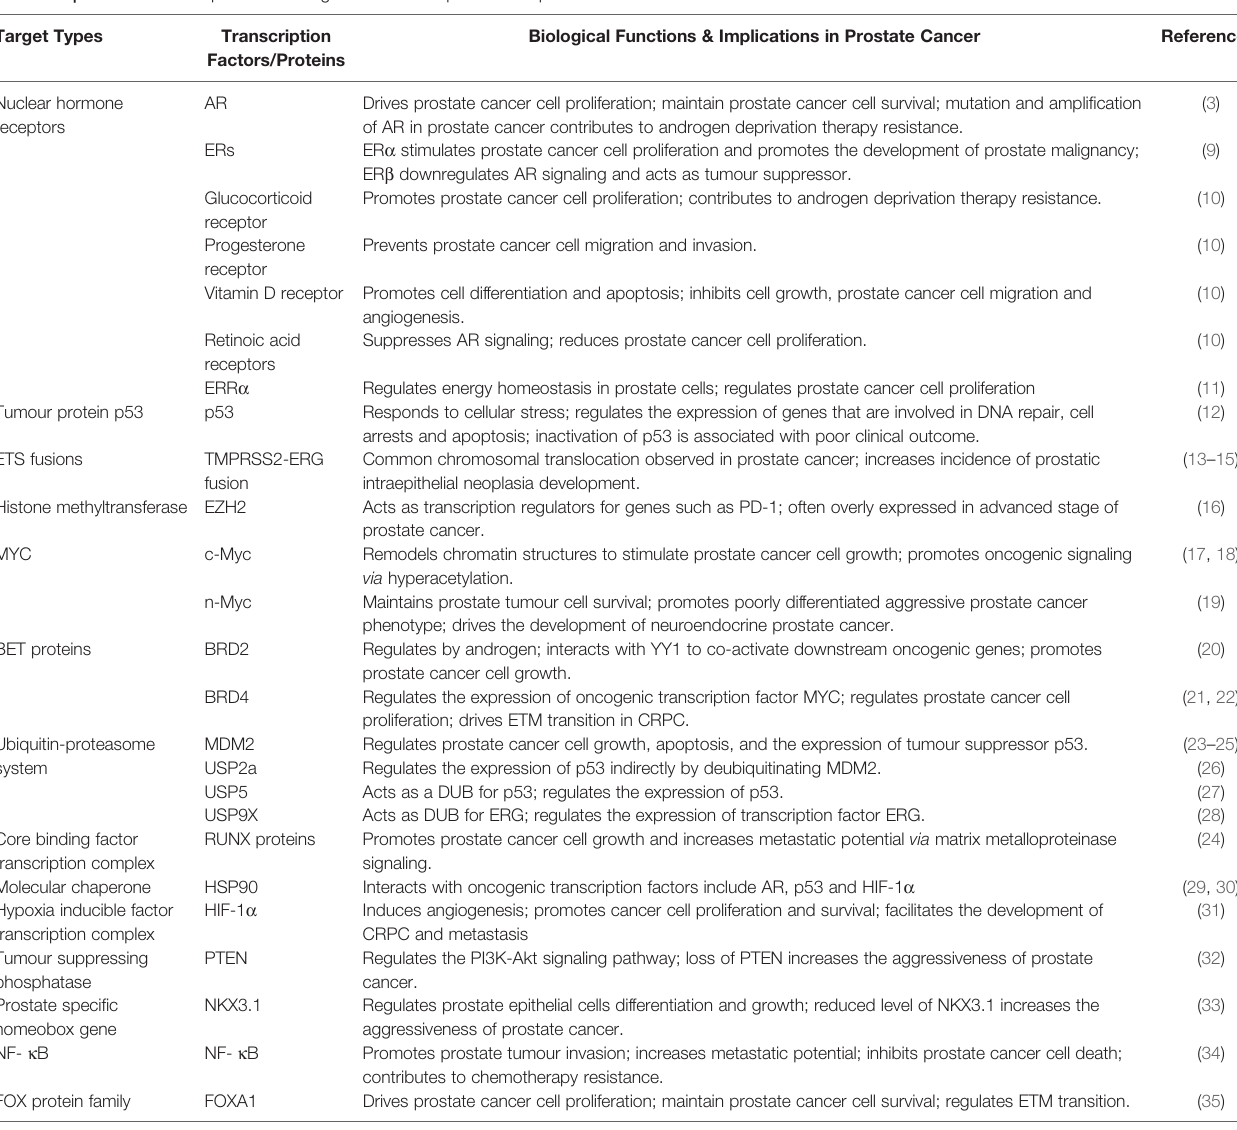
TABLE 1 | Identi fi ed transcription factor targets and their implications in prostate